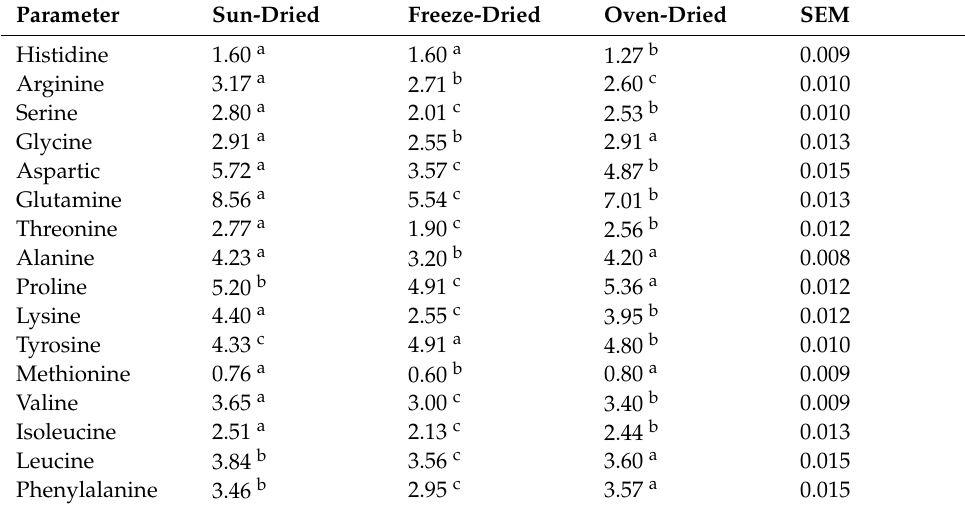
Table 4. Amino acid values of dried mealworm larvae (g/100